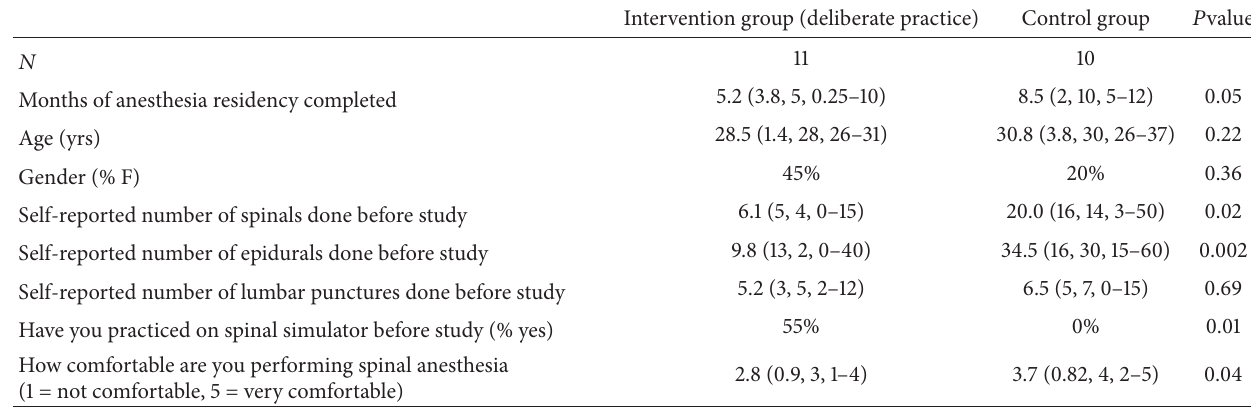
Table 2: Characteristics of residents enrolled in study (mean (SD, median, and